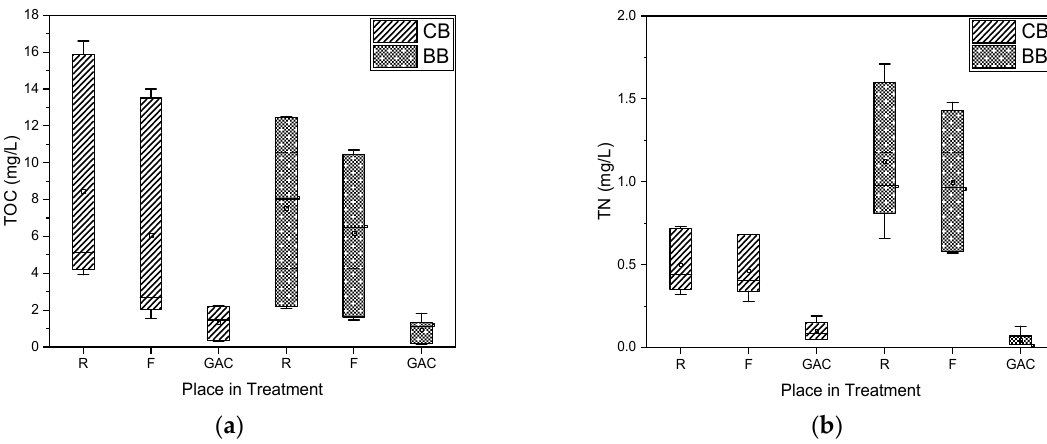
Figure 6. ( a ) TOC, and ( b ) TN precursor concentrations of processed samples, corresponding to the sample’s position in the treatment system. Samples were collected at three major phases during treatment: R = untreated raw water; F = dual-media filtration effluent; GAC = dual media filtration + GAC filtration effluent. Plots based off of all TOC and TN concentrations regardless of seasonal sampling event. CB = Cork Brook, BB = Bailey Brook.